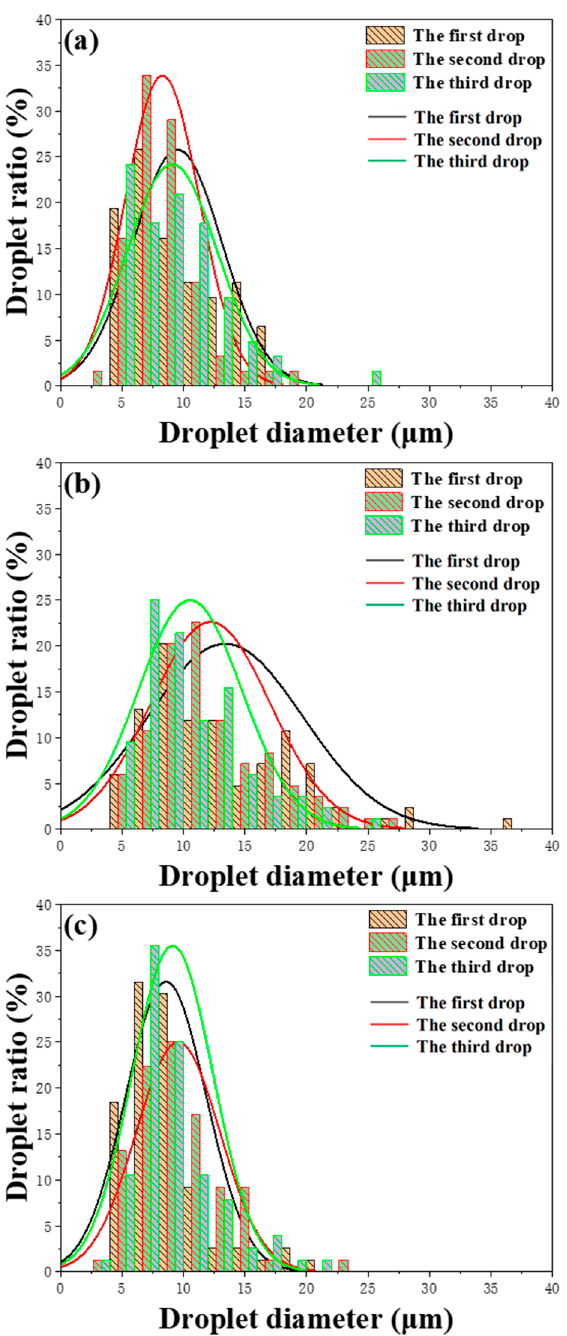
Figure 5. Statistical results of particle size of three drops of bio-oil Pickering emulsion randomly sampled. ( a ) CTAB-GO, ( b ) SiO 2 , ( c ) coconut shell coke. sampled. ( a ) CTAB-GO, ( b ) SiO 2 , ( c ) coconut shell